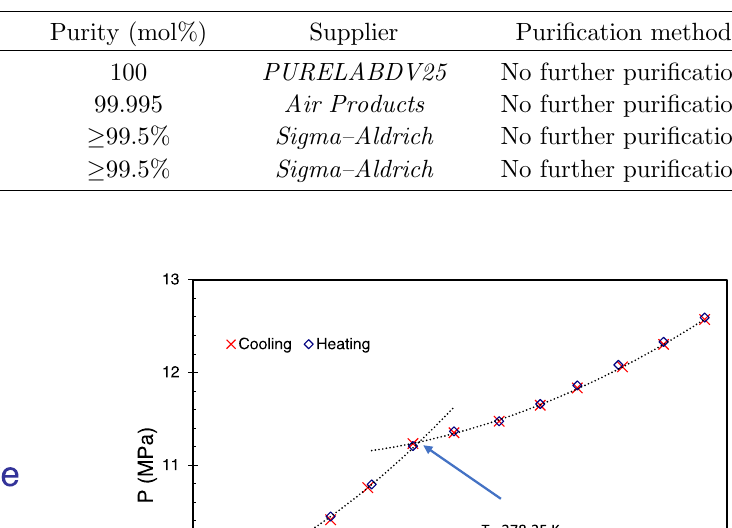
Table 3. Composition of the chemical used in this work.